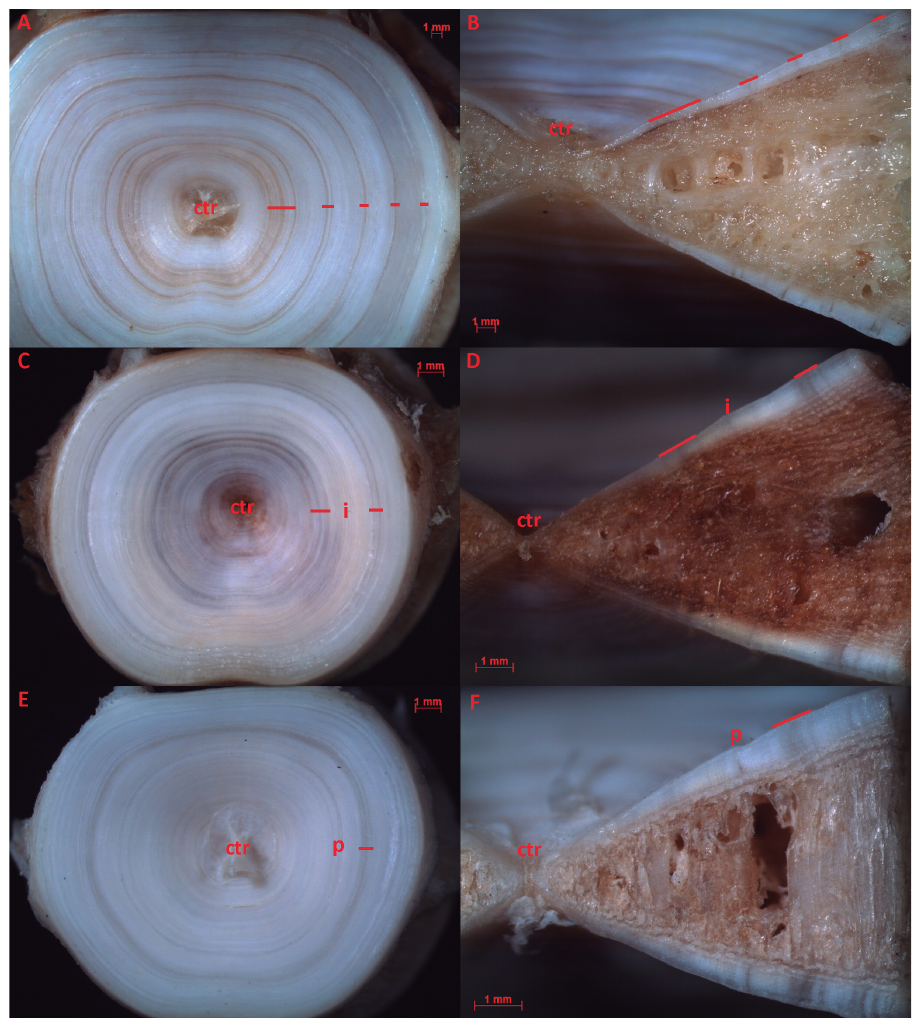
FIGURE 3 | Pseudoplatystoma punctifer vertebrae showing A–B . Five growth rings: the first one is multiple, the second one double and the third, fourth and fifth are simple, C–D . Two growth rings and E–F . One growth ring. Vertebrae center (ctr), hyaline rings (red lines), intermediate mark (i), pre mark (p). Left images: vertebrae frontal view. Right images: vertebrae cross section view with the confirmation of the rings on the corpus